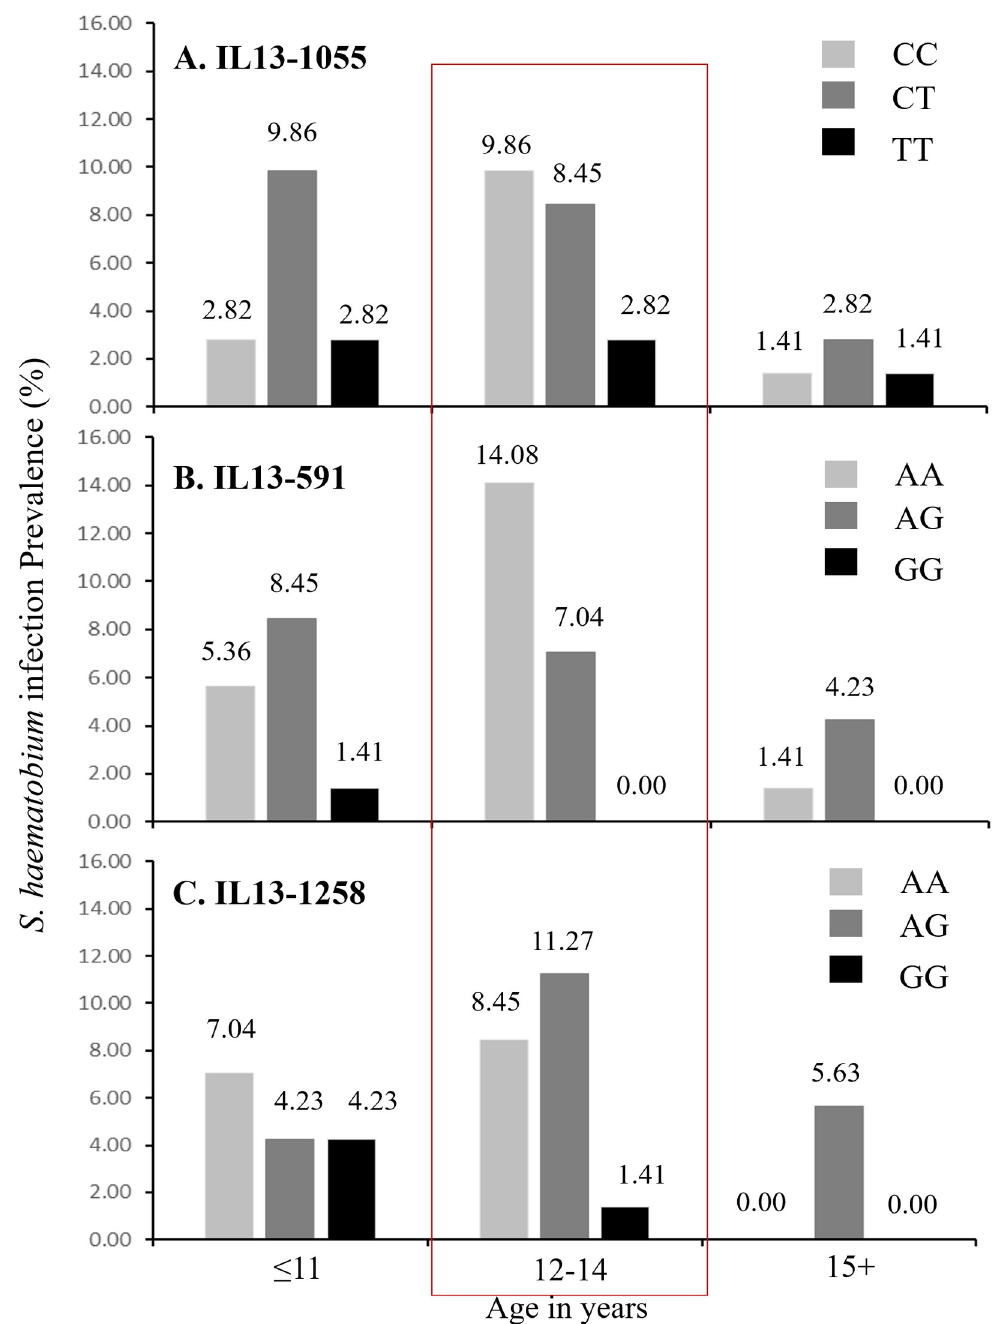
Fig 3. Percent S . haematobium infection prevalence distribution for (A) IL13-1055C/T, (B)IL13-591A/G, and (C)IL13- 1258A/G polymorphisms by age groups. The red rectangular border highlights an observed infection prevalence distribution trend with the 12-14-year age group that is apparent for all three